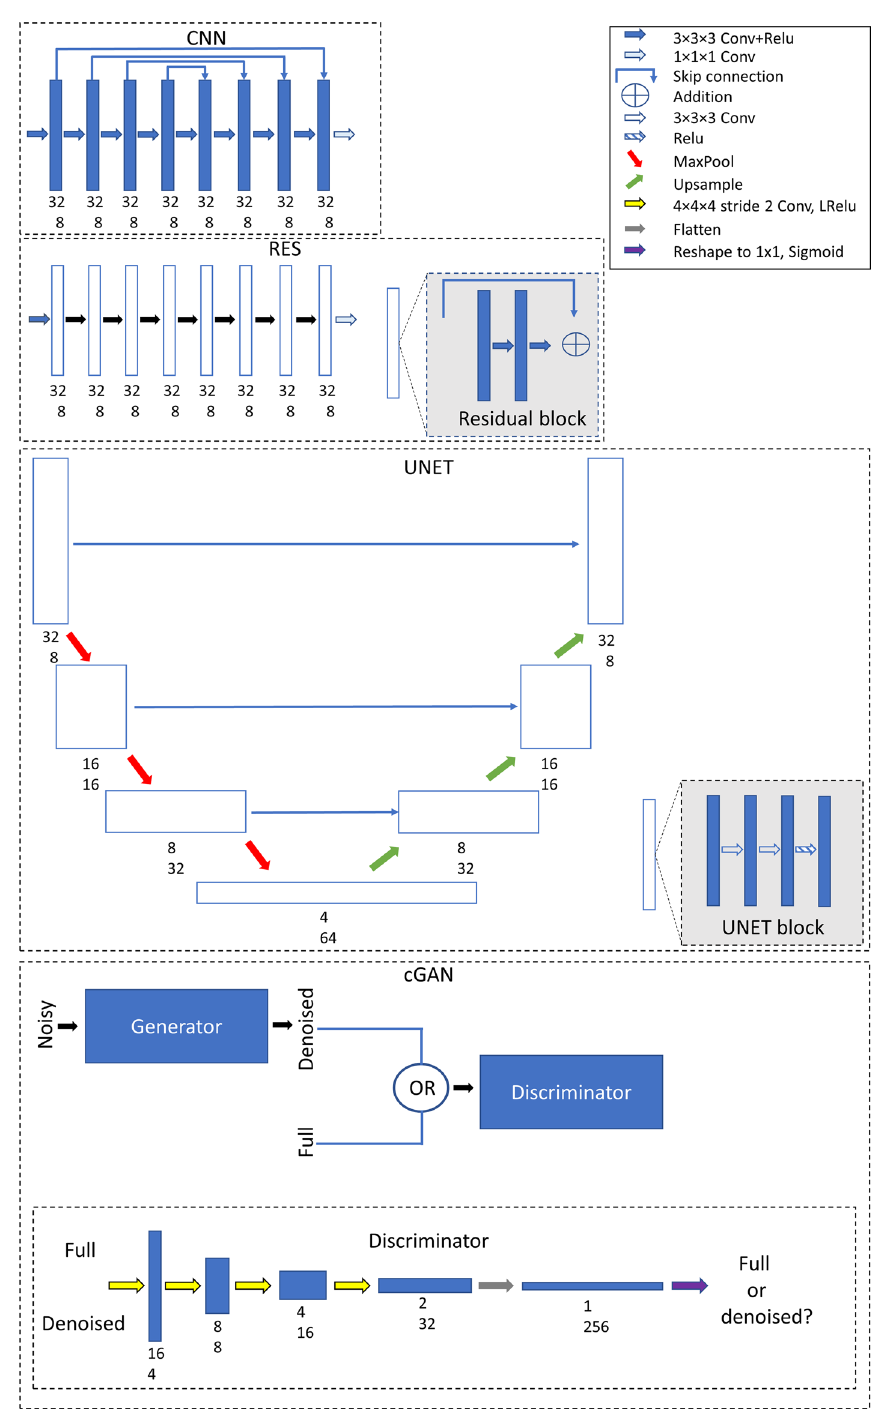
Fig. 1 DL models. The number under the blocks presents the patch size (upper number) and number of filters (lower number). Noisy 32 32 32 patches cropped from reduced acquisition time OSEM images were × × used as model input and model gave denoised 32 32 32 patches as output. Output patches were later × × combined using weighted averaging to produce images at the original reconstruction matrix